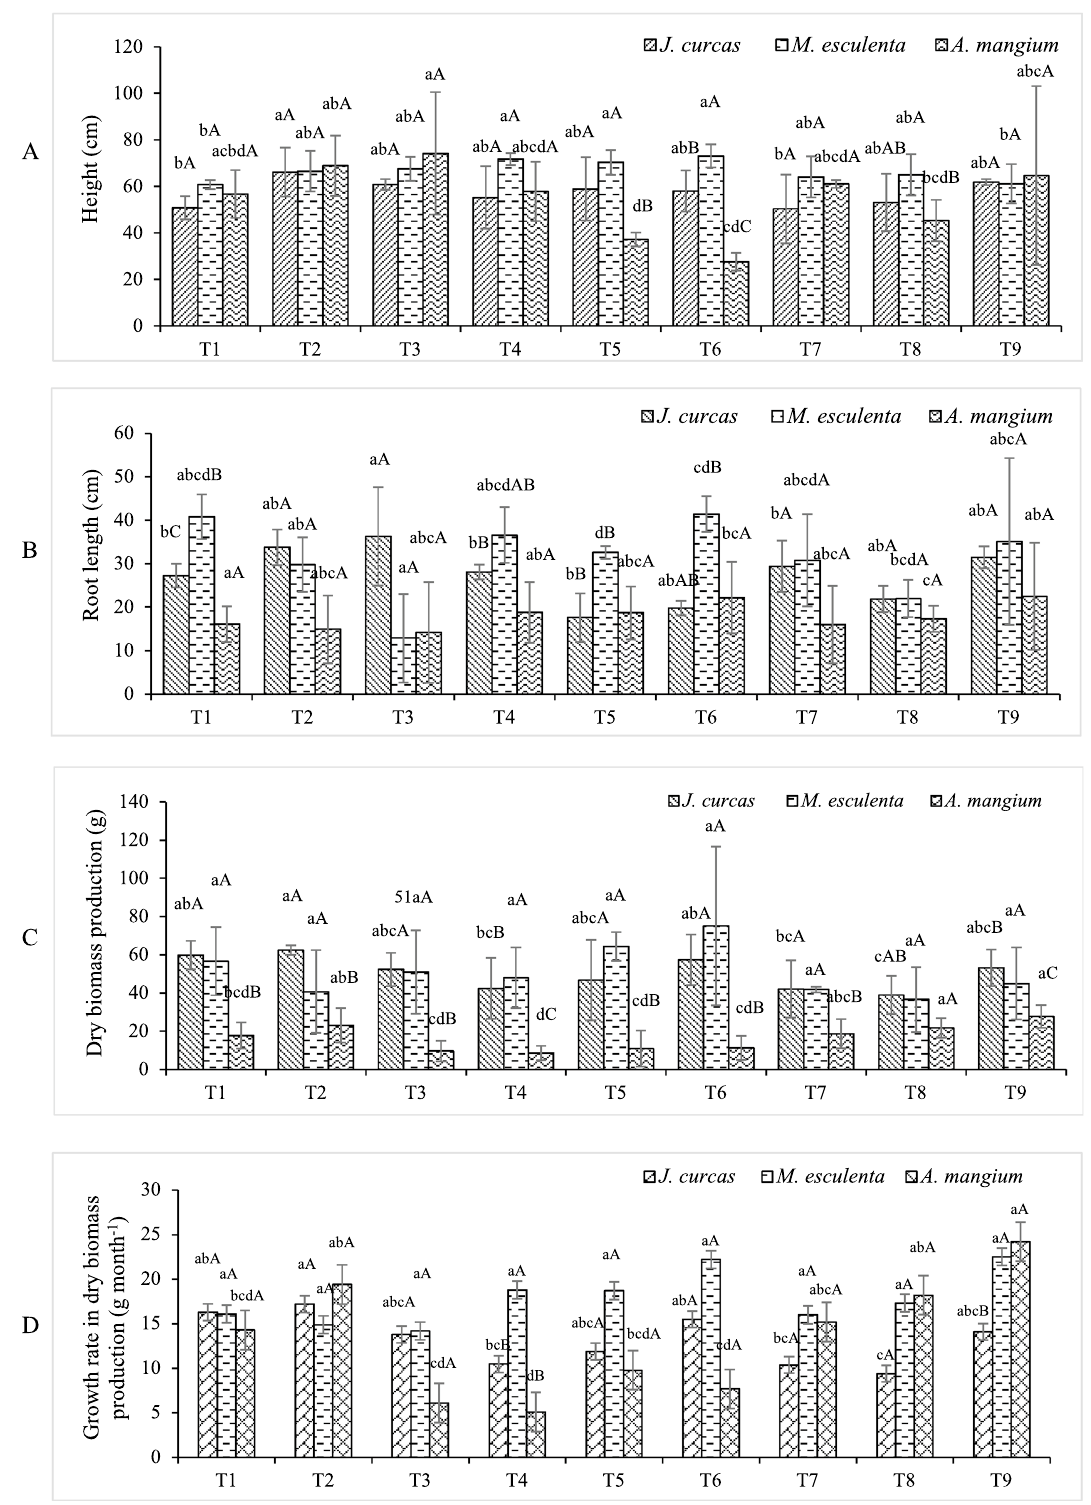
Figure 1. Growth performance of study plants and growth rate in dry biomass production, for 3 months ( n = 4). Values followed by the same letter are not significantly differ; lower case letters show the difference in growth performance among treatments within the same plant species (LSD, p < 0.05; Fig. 2A–D); capital letters show the difference in growth performance among plant species within the same treatment (LSD: p < 0.05; Fig. 2D). T1 = SL, T2 = SBM, T3 = SLBM, T4 = SLVC, T5 = LCM, T6 = LBM, T7 = BMVC, T8 = BMCM, T9 =